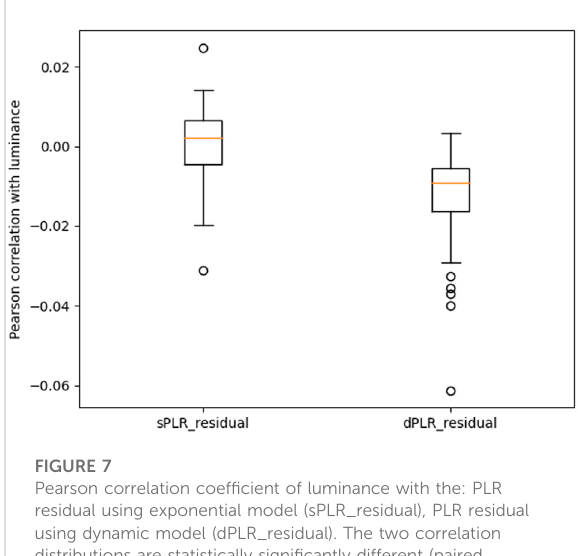
FIGURE 7 Pearson correlation coef fi cient of luminance with the: PLR residual using exponential model (sPLR_residual), PLR residual using dynamic model (dPLR_residual). The two correlation distributions are statistically signi fi cantly different (paired Wilcoxon test with p-value less than 0.001). Correlation is not a good indicator of attenuation of luminance effects.